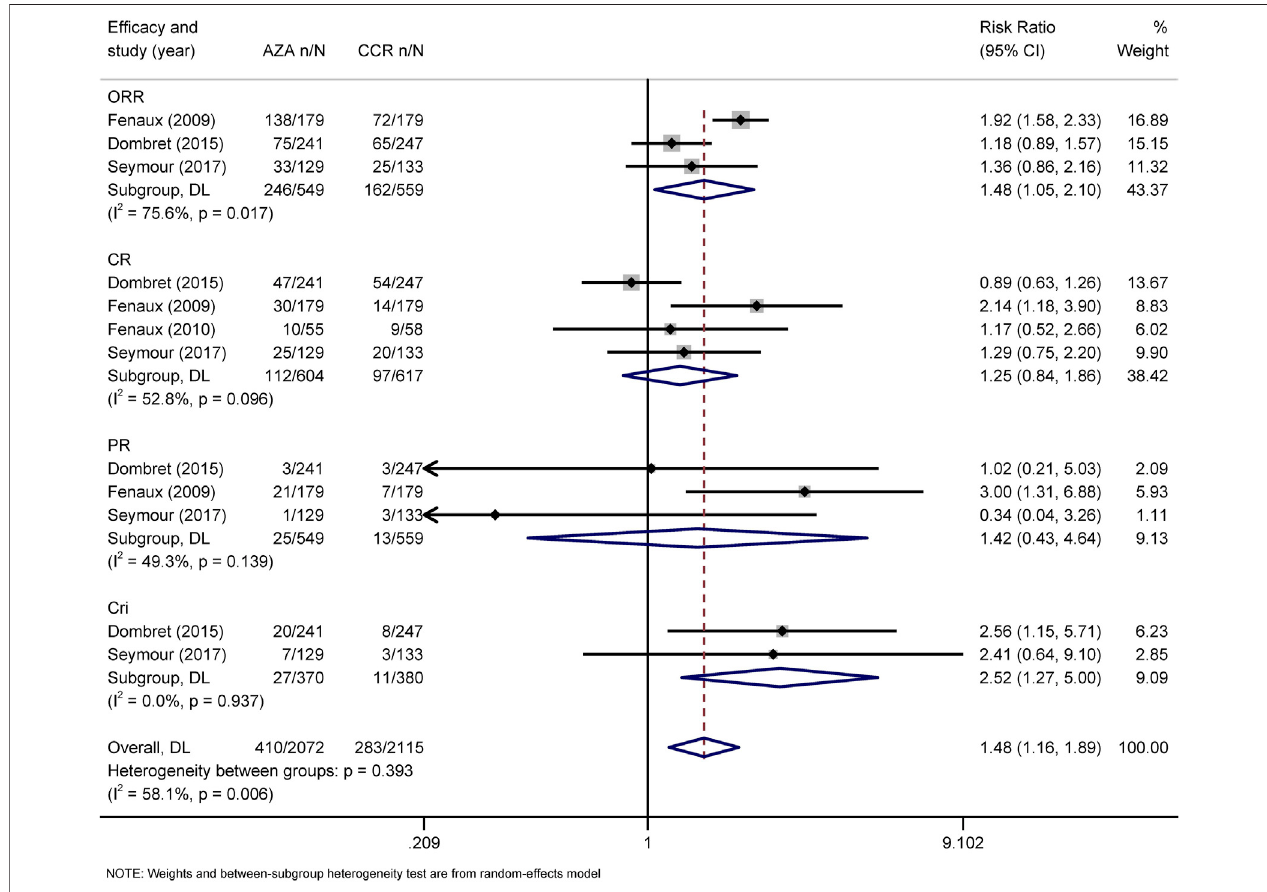
FIGURE 4 | Forest plot of ef fi cacy of azacitidine vs. conventional care regimens (direct evidence-RR). Forest plot represents the direct comparison of ef fi cacy between AZA and CCR. RR, relative risks; 95%CIs, 95% con fi dence intervals; CCR, conventional care regimens; n, total number of events; N, total number of patients.